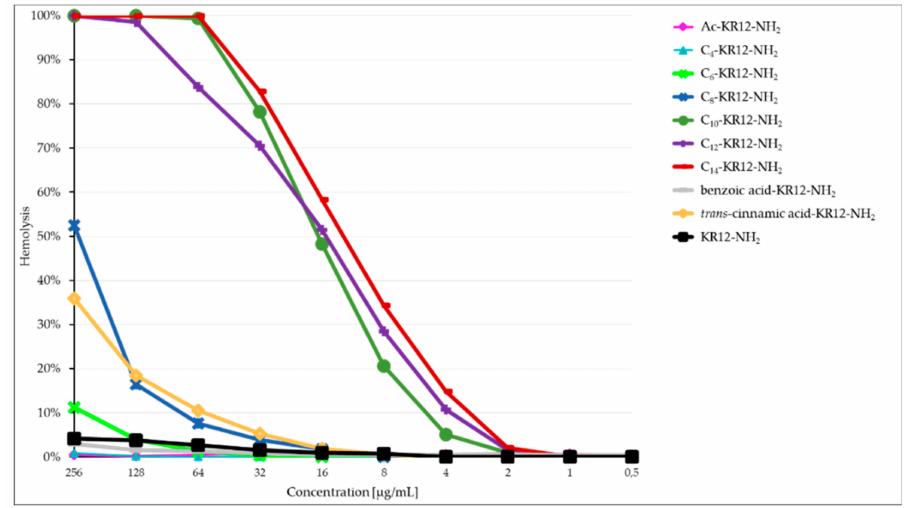
Figure 3. Percentage of hemolysis of erythrocytes versus peptide